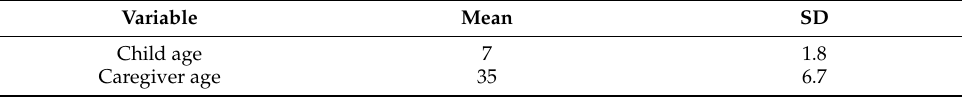
Table 1. Sociodemographic characteristics of study respondents.